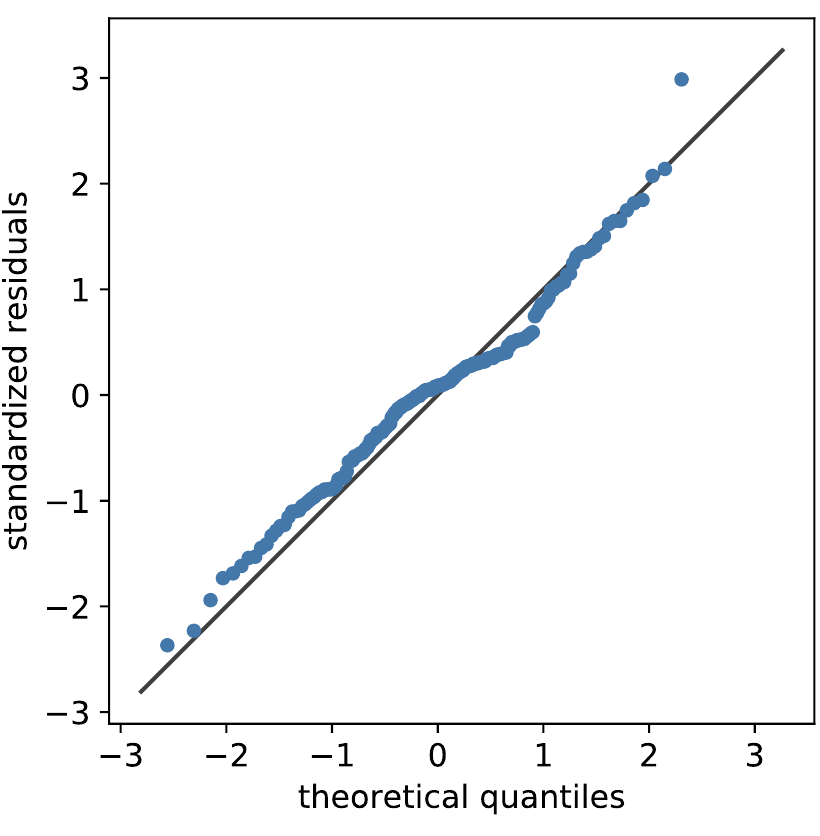
Figure 12. QQ-plot [68,69] of the standardized residuals against the theoretical quantiles of a normal distribution, revealing an approximately normal distributed error.